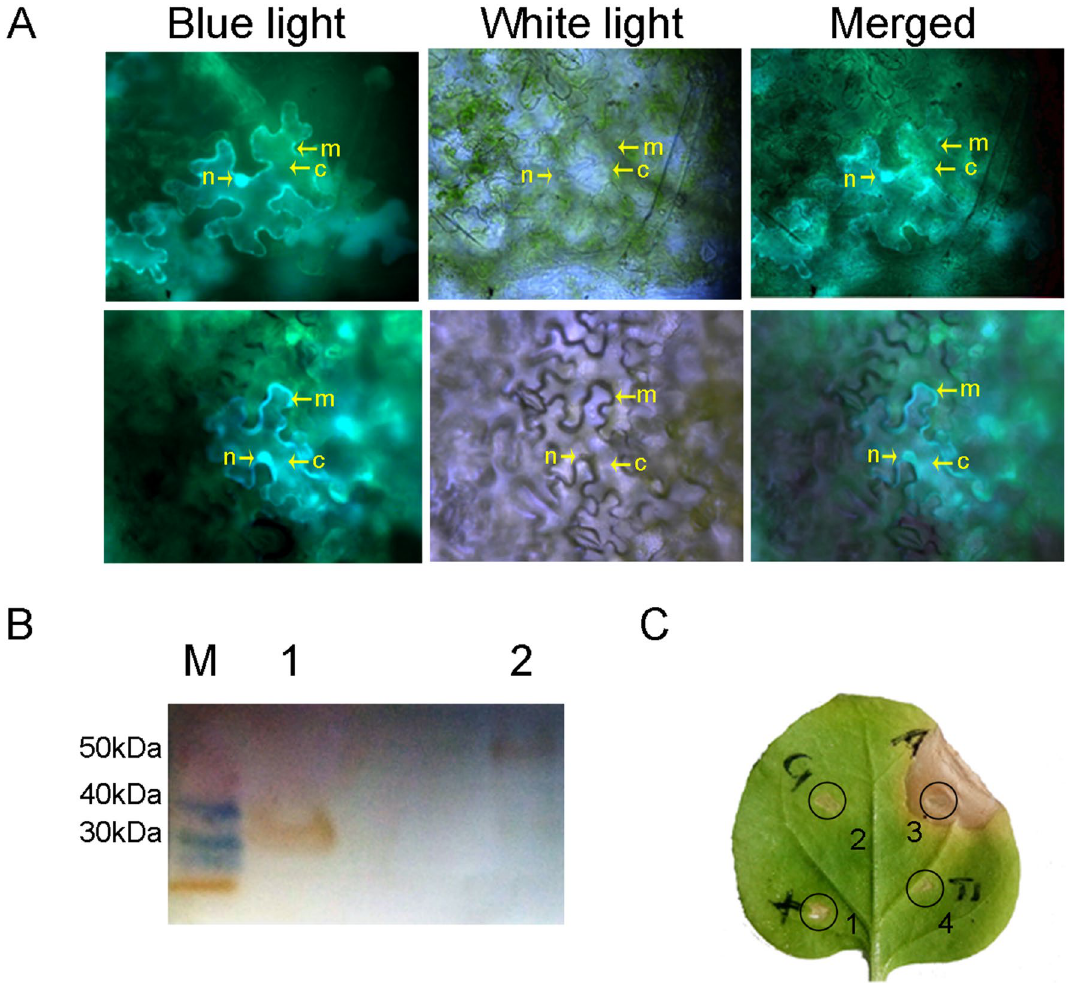
Figure. 9. Subcellular localization and transient expression of Ab -ATPS from Aphelenchoides besseyi in tobacco epidermal cells. ( A ) Ab -ATPS-GFP localized at the membrane, plasma, and nucleus in tobacco epidermal cells. ( B ) Ab -ATPS-GFP expression was detected by Western-blot. M: Protein Marker (Transgene); 1: Protein mix of GFP extracted from tobacco leaves; 2: Protein mix of Ab -ATPS-GFP extracted from tobacco leaves. ( C ) Ab -ATPS-GFP triggered cell death. 1: 2-(N-Morpholino) ethanesulfonic acid hydrate (MES) buffer; 2: pCAMBIA1300-GFP; 3: pCAMBIA1300- Ab -ATPS-GFP; 4: pCAMBIA1300 empty vector. n: nuclear, c: cytoplasm, m: membrane. GFP: protein was generated with green fluorescent